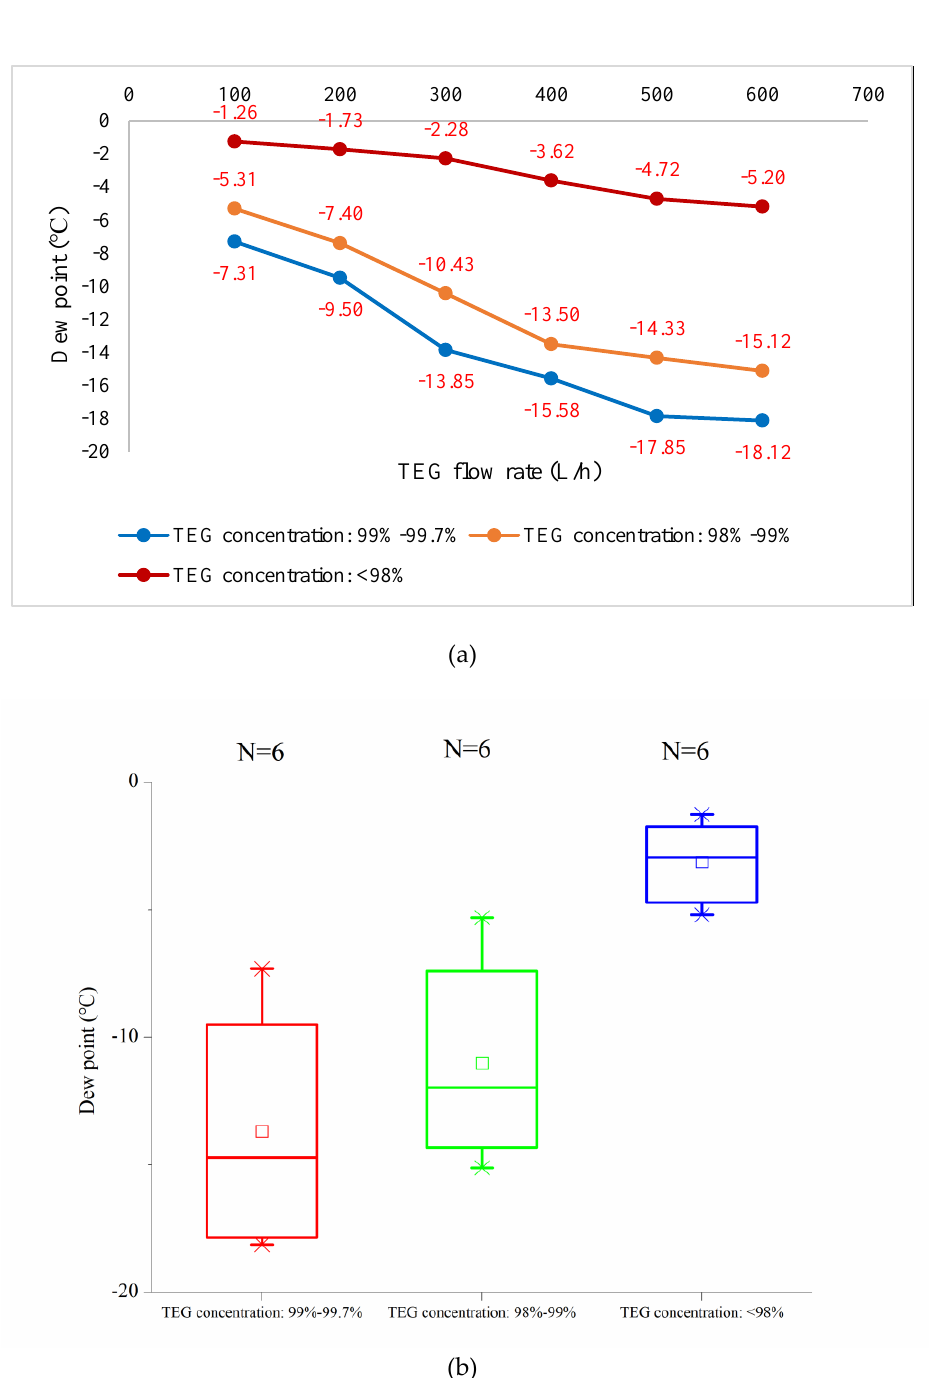
Figure 5. Effect of TEG flow rate on dew point. ( a ) Experimental data; ( b ) Box-plot. Figure 5. E ff ect of TEG flow rate on dew point. ( a ) Experimental data; ( b )